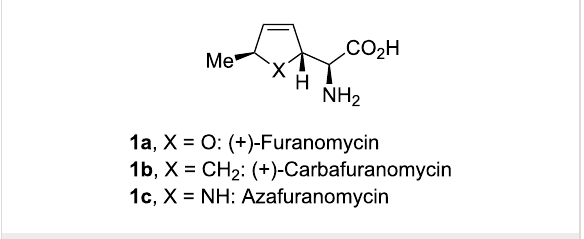
Figure 1: Structure of furanomycin and its carba- and aza-anolgue.